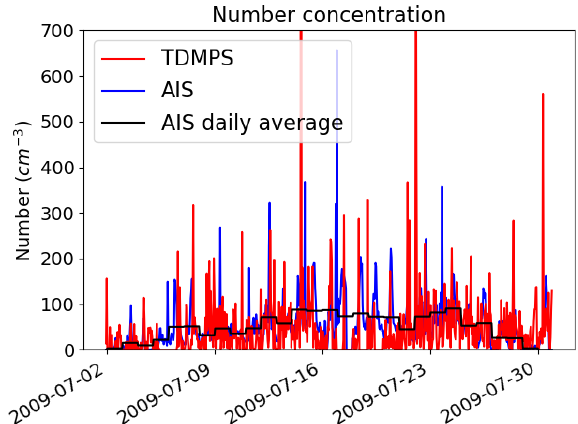
Figure 2. Number of particles with diameters lower than 5nm, as measured with the AIS (in blue) and TDMPS (in red). The black lines represent the average daily number concentrations measured with the